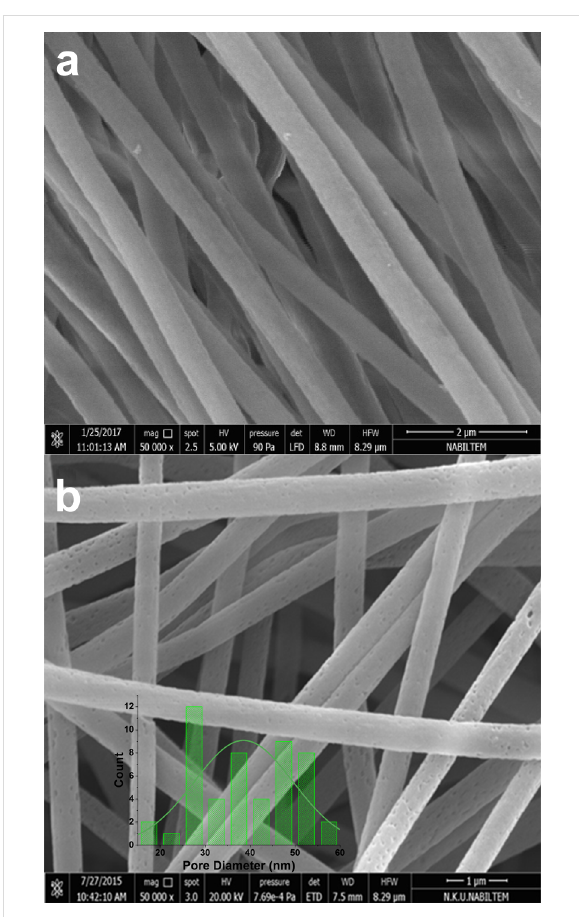
Figure 11: SEM images of (a) oxidized PAN nanofiber webs and (b) GO-containing oxidized PAN nanofiber webs with pore distribution